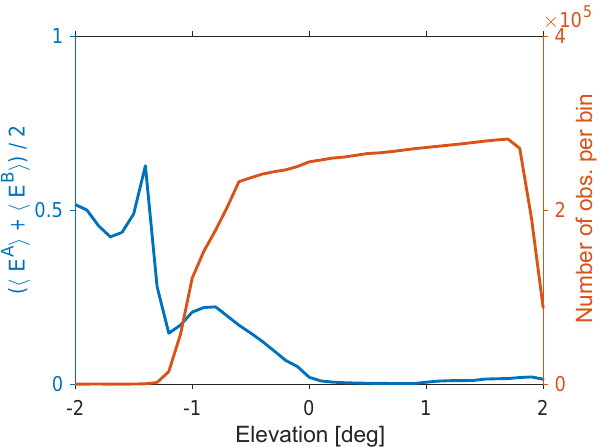
Figure 8. Failure rate of internal navigation bit retrieval in terms of averaged performance parameter (cid:104) E (cid:105) (Eq. 10) as a function of elevation angle for signal density ratios C /N 0 ≥ 30dBHz (blue, left axis). The corresponding number of observations per elevation bin is plotted as well (red, right axis). The statistics is based on 242 observations recorded in January 2014.